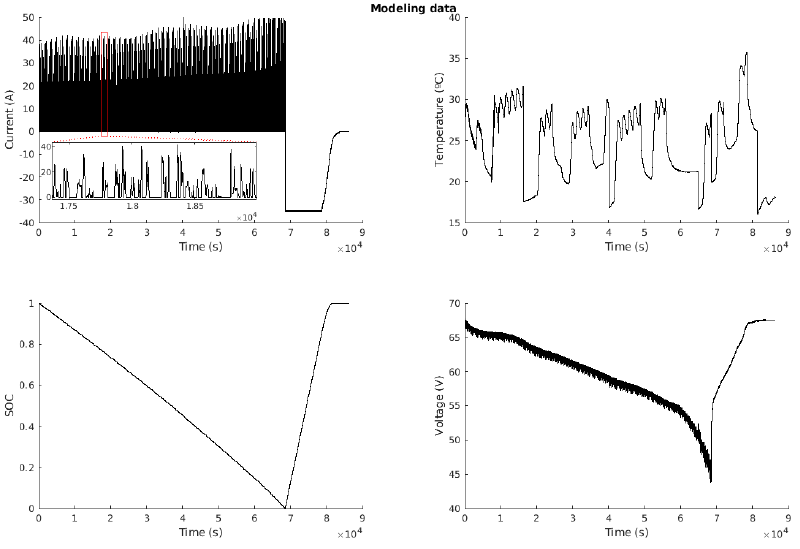
Figure 6. Modeling